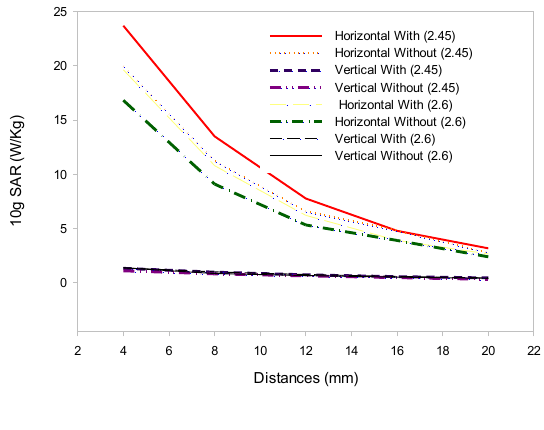
Figure 7: Result of 10g SAR at 2.45GHz and 2.6GHz